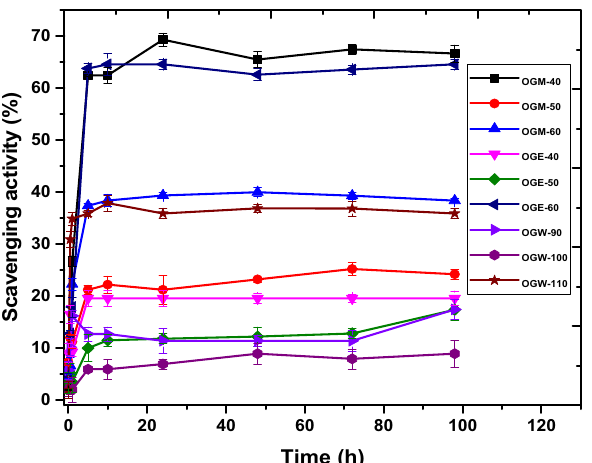
Figure 1. Antioxidant activity of O. gratissimum extract (results are mean values of three replicates [n = 3] expressed in percentage; bars represent standard deviations).